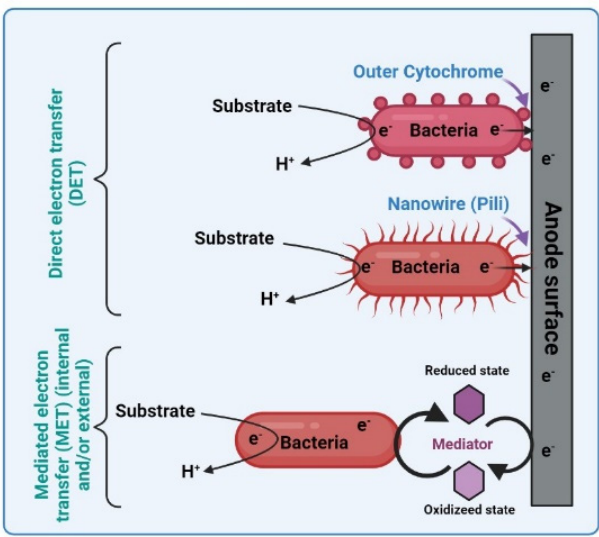
Figure 1. Mechanisms of direct electron transfer (DET) and mediated electron transfer (MET). Po- tential interactions between shuttle producers and no producer bacteria in an electroactive biofilm can occur as no producers can use such molecules as mediators to deliver e − to the anode. No pro- ducers transfer electrons directly to the